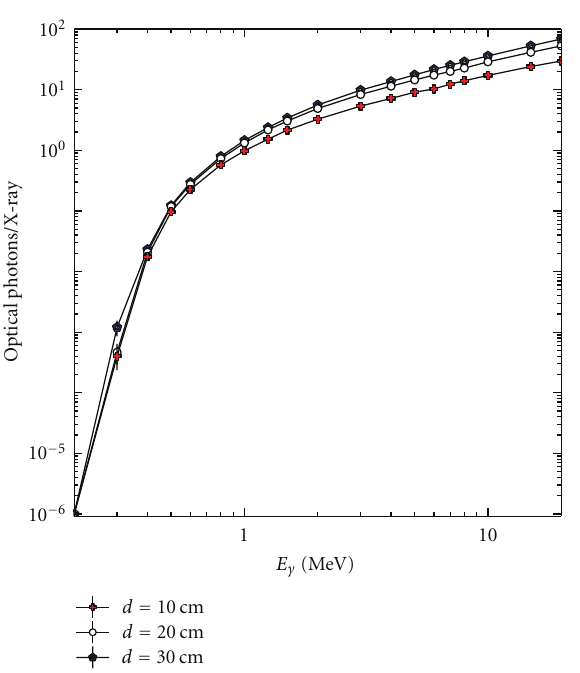
Figure 9: The number of Cerenkov photons (that are generated in the detector and reach the AMFPI) per X ray incident on the water phantom as a function of X-ray